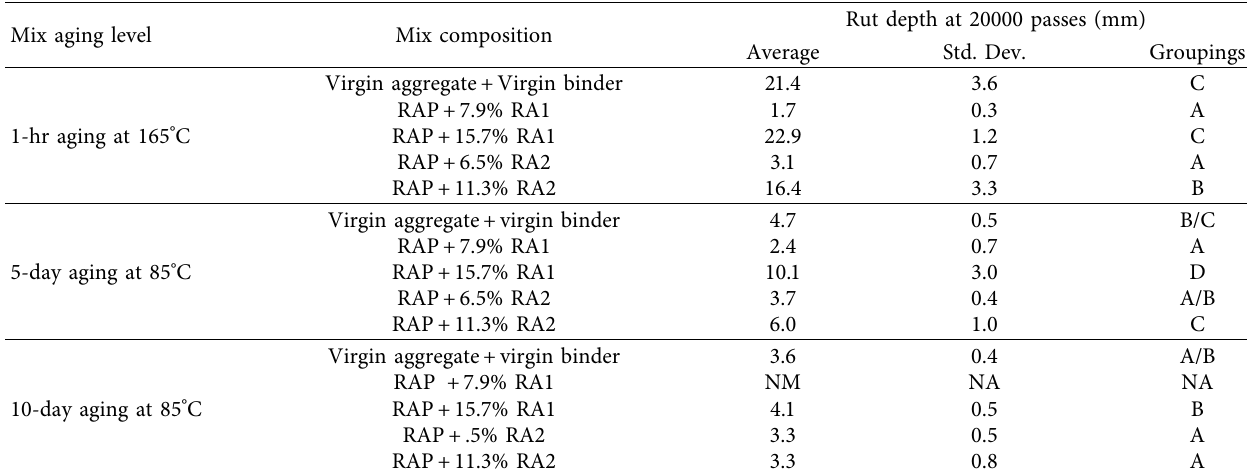
Figure 2: LWT test results, 50 ° C wet. Table 7: LWT rut depth test results, 50 ° C wet.